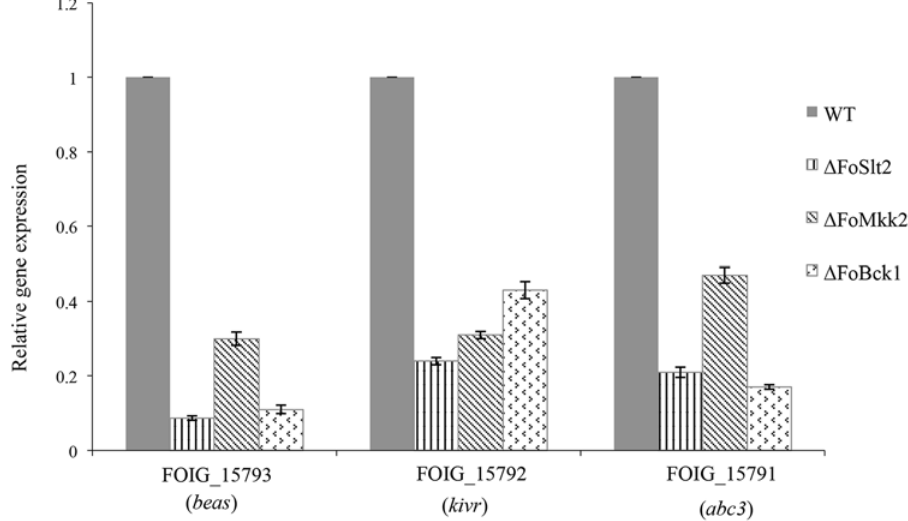
Fig 6. The MAP kinases affect the transcription of beauvericin biosynthetic genes. Gene expression levels are represented relative to WT using quantitative real-time PCR. Error bars indicate the standard error from three